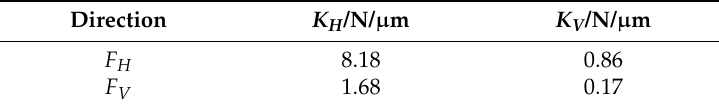
Figure 13. Mesh of the piezo jet dispenser with a diamond amplifier. The multi physics field coupling simulation of the piezo jet dispenser with a diamond Amplifier is carried out by using the piezoelectric module of Comsol. With Comsol, the voltage function with time applied to piezoelectric ceramics in one cycle is approximate as the Equation (23). ( )